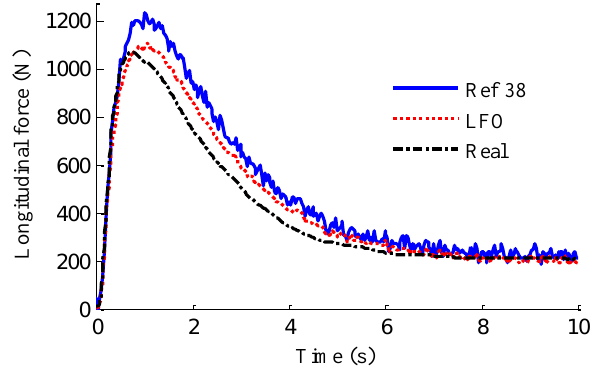
Figure 20. Estimation of longitudinal force.